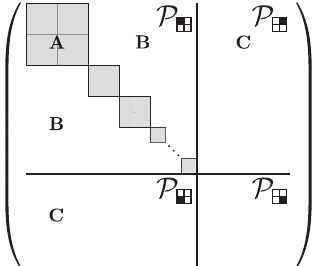
FIG. 2. Sketch of regions of linear response of the asymptotic subspace As ð H Þ (gray) to a Hamiltonian perturbation. Each of three regions A , B , and C corresponds to the respective response term Eqs. (4.6a), (4.6b), and (4.6c) in the